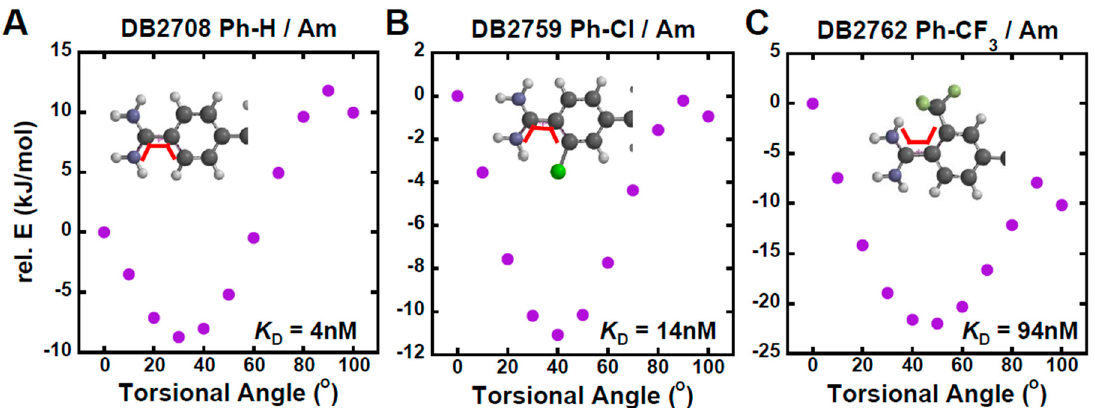
Figure 6. Torsional angle maps of a Ph-Am bond for ( A ) DB2708, ( B ) DB2759 and ( C ) DB2762. All calculations are performed at the B3LYP/6-31G * level of theory. The range of dihedral angle is from 0°–100°. The scanned dihedral is shown as the red bold line at 0°.